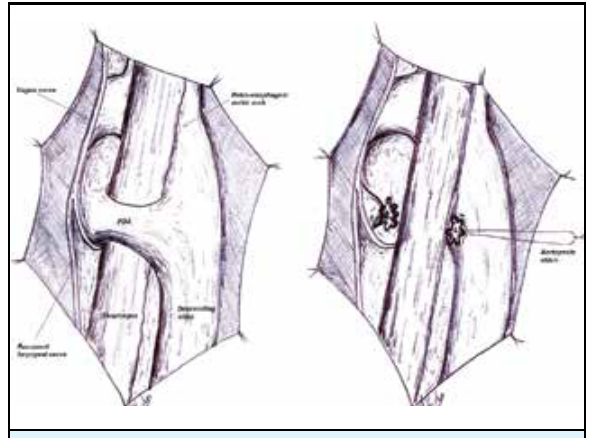
Figure 1. Diagram showing the intra-operative surgical findings: A) before and B) after ligation, division of the patent arterial duct and aortopexy. PDA: patent arterial